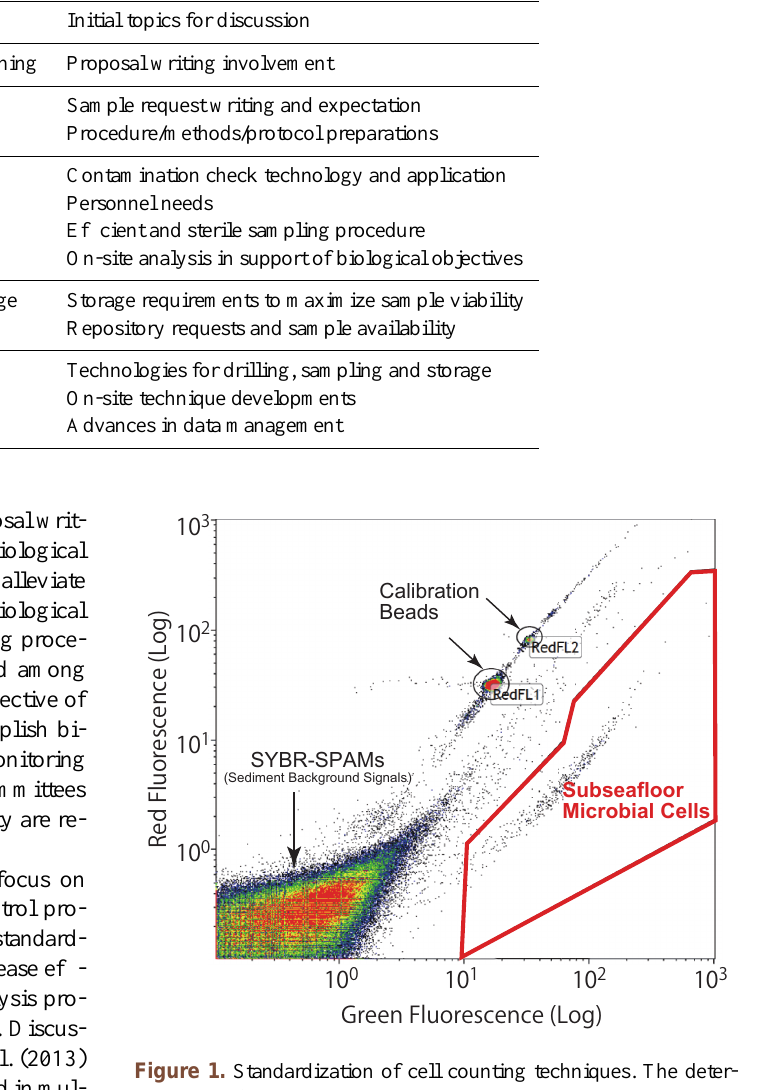
Table 1. Sections and topics to be included in the DEEP BIO Handbook.